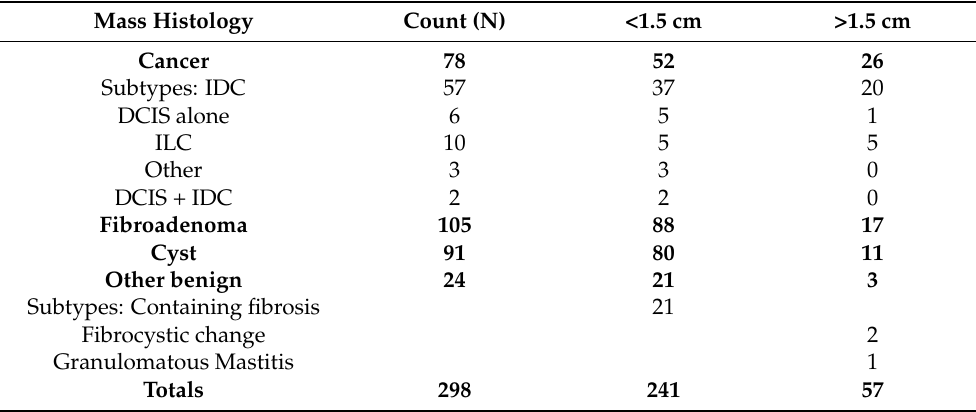
Table 2. Mass type and size distributions, including subtypes (unbolded) of cancer and other benign categories as noted. (IDC = invasive ductal carcinoma; DCIS = ductal carcinoma in situ; other = 1 mammary, 1 mucinous,1 papillary carcinoma; ILC: invasive lobular carcinoma). The smaller (i.e., <1.5 cm) other benign masses commonly showed underlying fibrosis, noted from biopsy reports (i.e., 13% (21/161) of solid